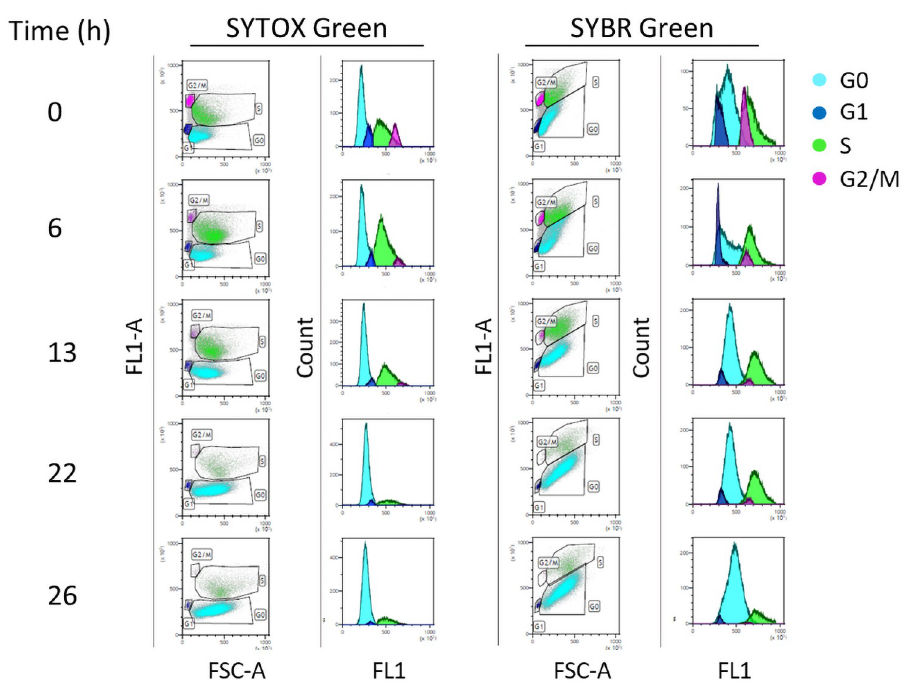
Fig 4. Analysis of S. cerevisiae cell cycle during the feeding phase of the cultivation by either SYTOX Green or SYBR Green staining. The figure shows both bi-dimensional (dot plots, FL1-A vs FSC-A) and mono-dimensional analysis (histograms of